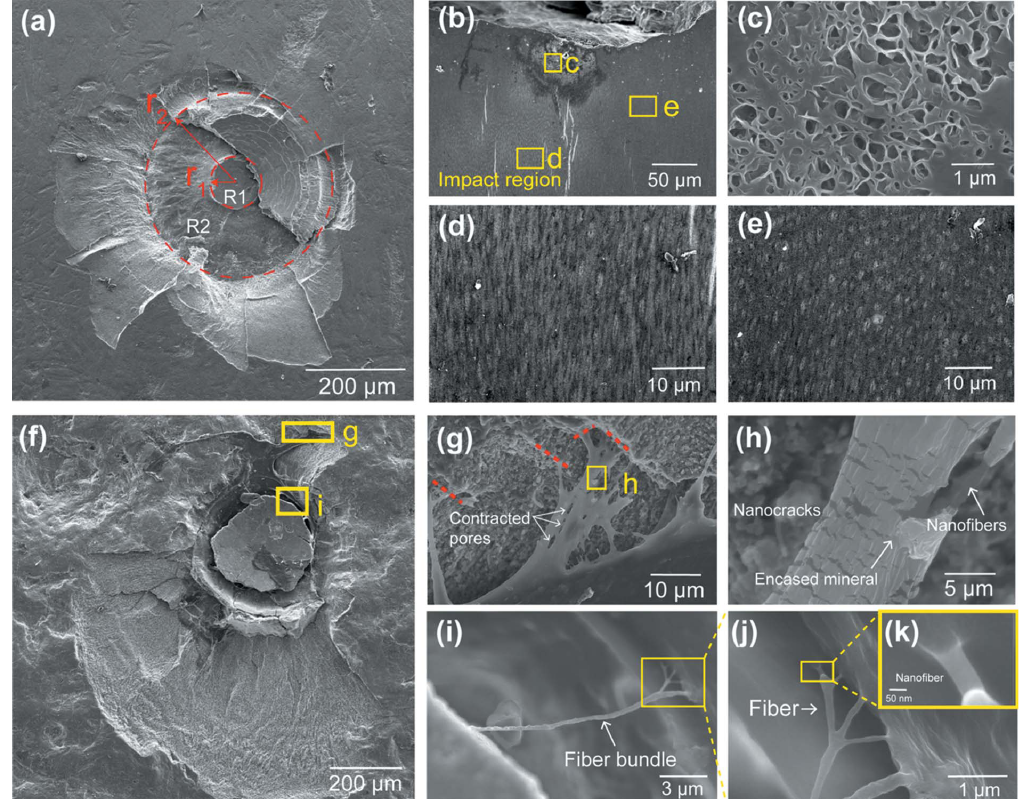
Figure 4 Morphologies and deformation mechanisms in the damaged dactyl surface. ( a ) SEM image of the damaged surface of hydrated dactyl club samples, impacted at a speed of 160 m s (cid:2) 1 . For convenience, we labeled the surface area with the R1 and R2 regions according to a different radius from the central impacting point. ( b )–( e ) SEM images of the cross-section of damaged hydrated dactyl club. ( b ) Low-magnification SEM image showing both plastic and elastic regions formed beneath the impact point. ( c ) Region featuring large pores owing to the loss of mineral contents. ( d ) Enlarged view showing a typical plastic zone feature. ( e ) Enlarged view showing an elastic zone with a textured arrangement. ( f ) SEM image of a damaged surface of dactyl clubs with a rough surface. ( g ) The in-plane fibers were pulling out from different layers (highlighted with red lines). ( h ) Nanocracks in encased mineral of nanofibers and the separation of clustered nanofibrils. ( i )–( k ) Fiber bridging near the impact point, illustrating the hierarchical fiber bridging: ( i ) fiber bundle, ( j ) fiber and ( k )